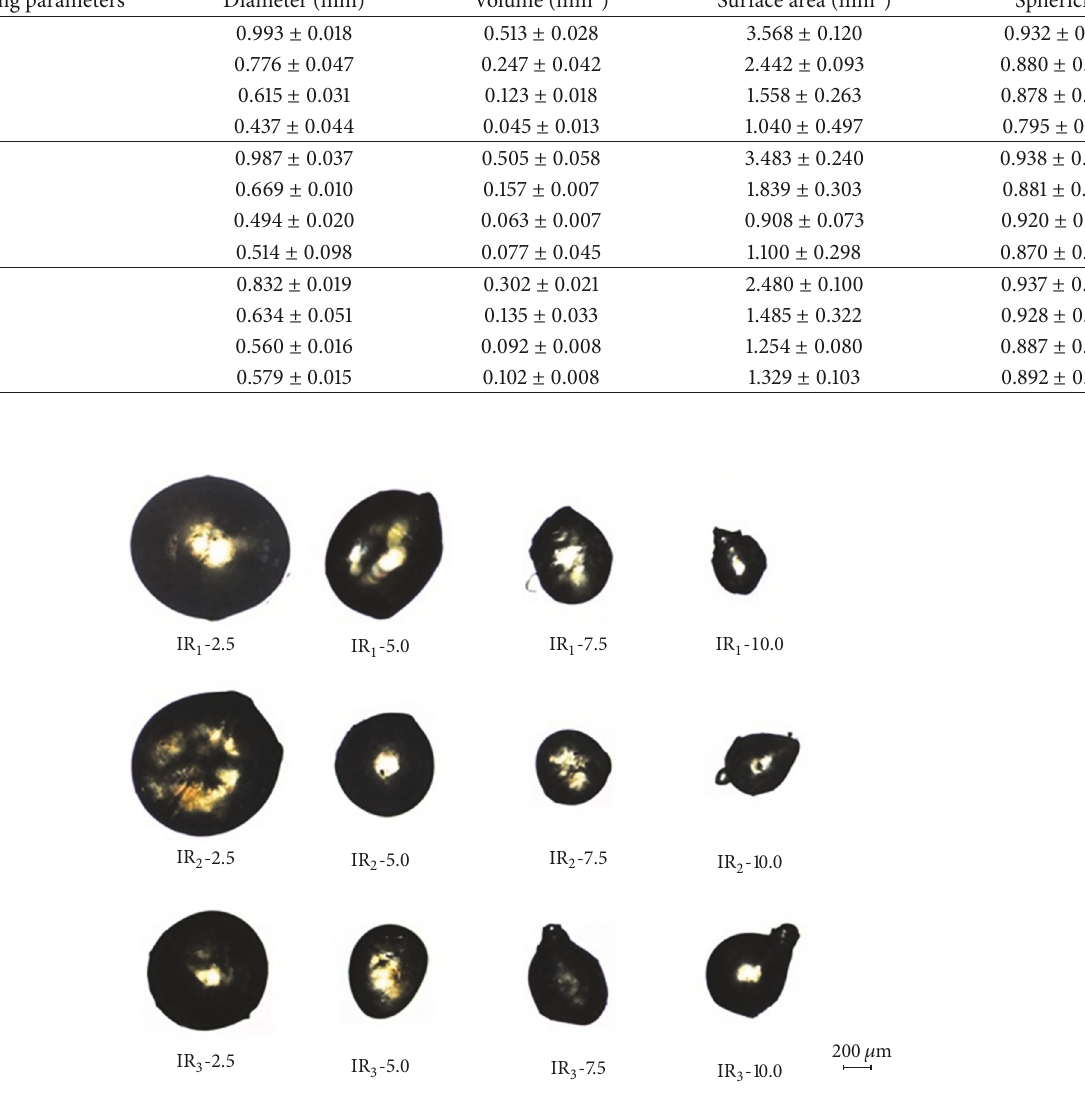
Figure 3: Chitosan microspheres optical microscopy images prepared at three injection flow rates: 0.150 mL ⋅ min −1 (IR 1 ), 0.300 mL ⋅ min −1 (IR 2 ), and 0.600 mL ⋅ min −1 (IR 3 ) and four airflow rates (2.5, 5.0, 7.5, and 10.0 L ⋅ min −1